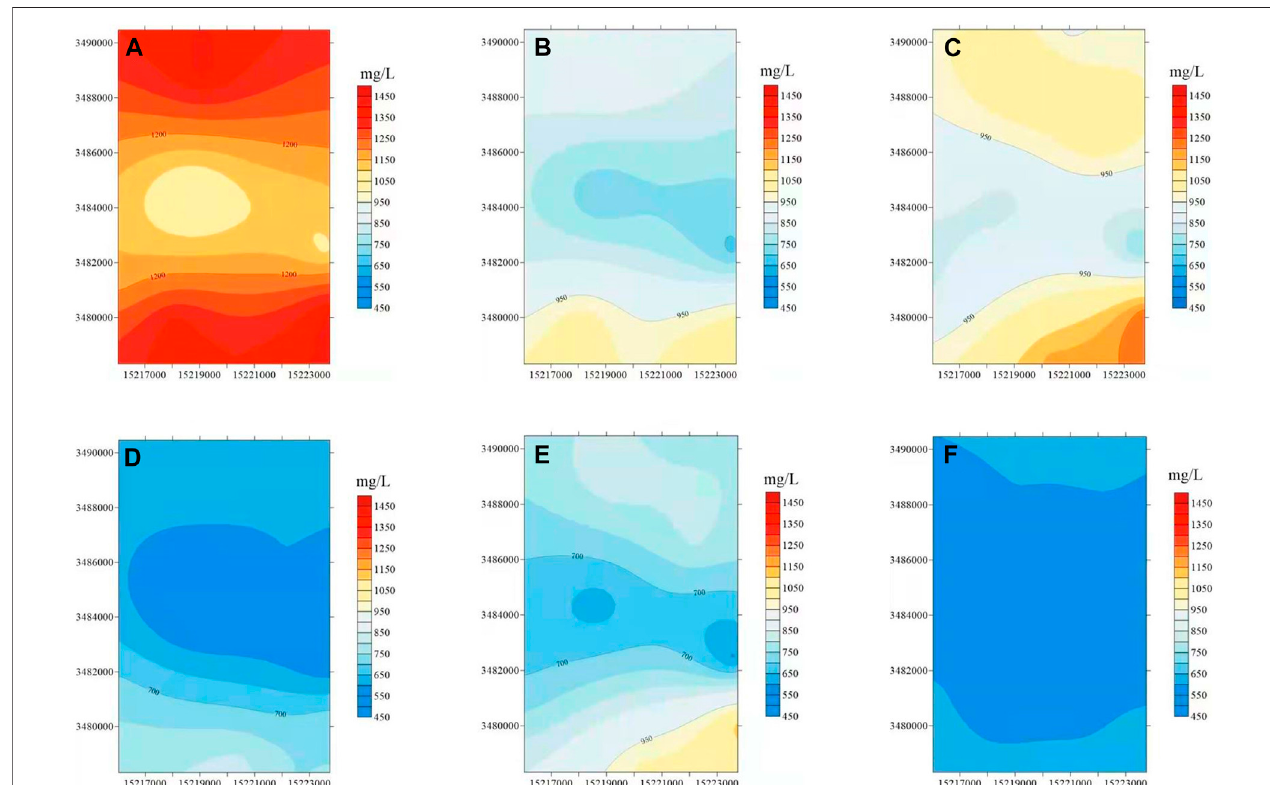
FIGURE 14 | The spatial and temporal distribution of lithium ion concentration in the North Lake of Zabuye Salt Lake [ (A) 1991 – 2000 February, (B) 1991 – 2000 August, (C) 2001-2010 February, (D) 2001 – 2010 August, (E) 2011-2020 February, (F) 2011 – 2020 August).